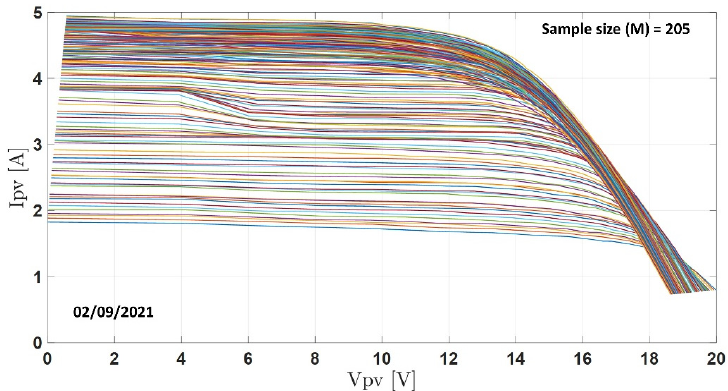
Figure 6 . The 205 I–V characteristics in the healthy case measured on 2 September 2019 .